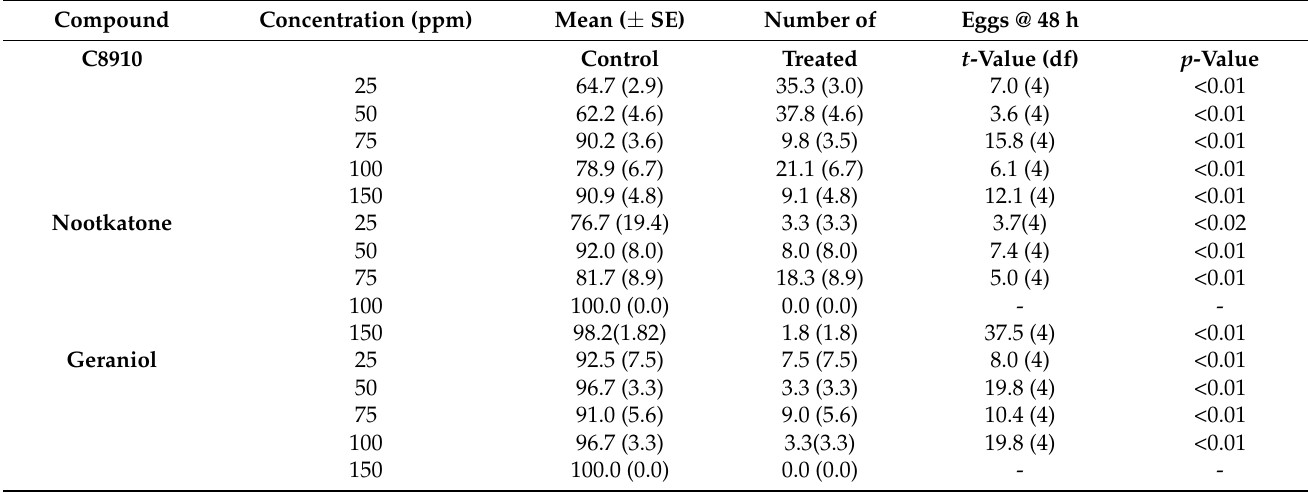
Table 3. Mean proportions of eggs laid by T. putrescentiae ( ± SE; n = 5) on small dry-cured ham pieces treated with various food-safe compounds compared to untreated ham pieces after 48 h in a laboratory two-choice behavior bioassay. Student’s t -tests following arcsine transformations of proportions were